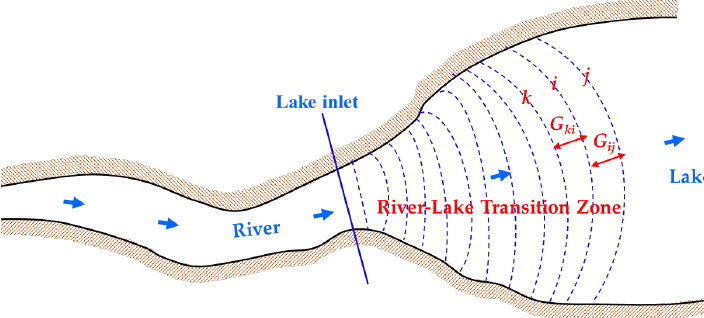
Figure 5. Diagram of the flow velocity gradient at the lower boundary of the river–lake transition zone.